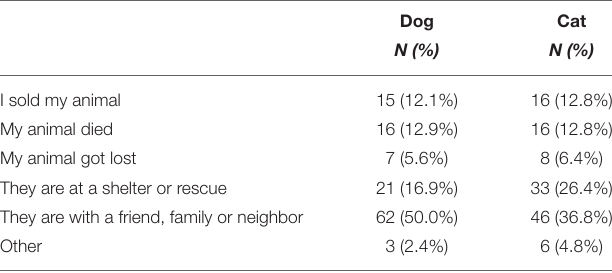
TABLE 6 | Results of binary logistic regression model assessing factors associated with rehoming a dog and/or cat during the